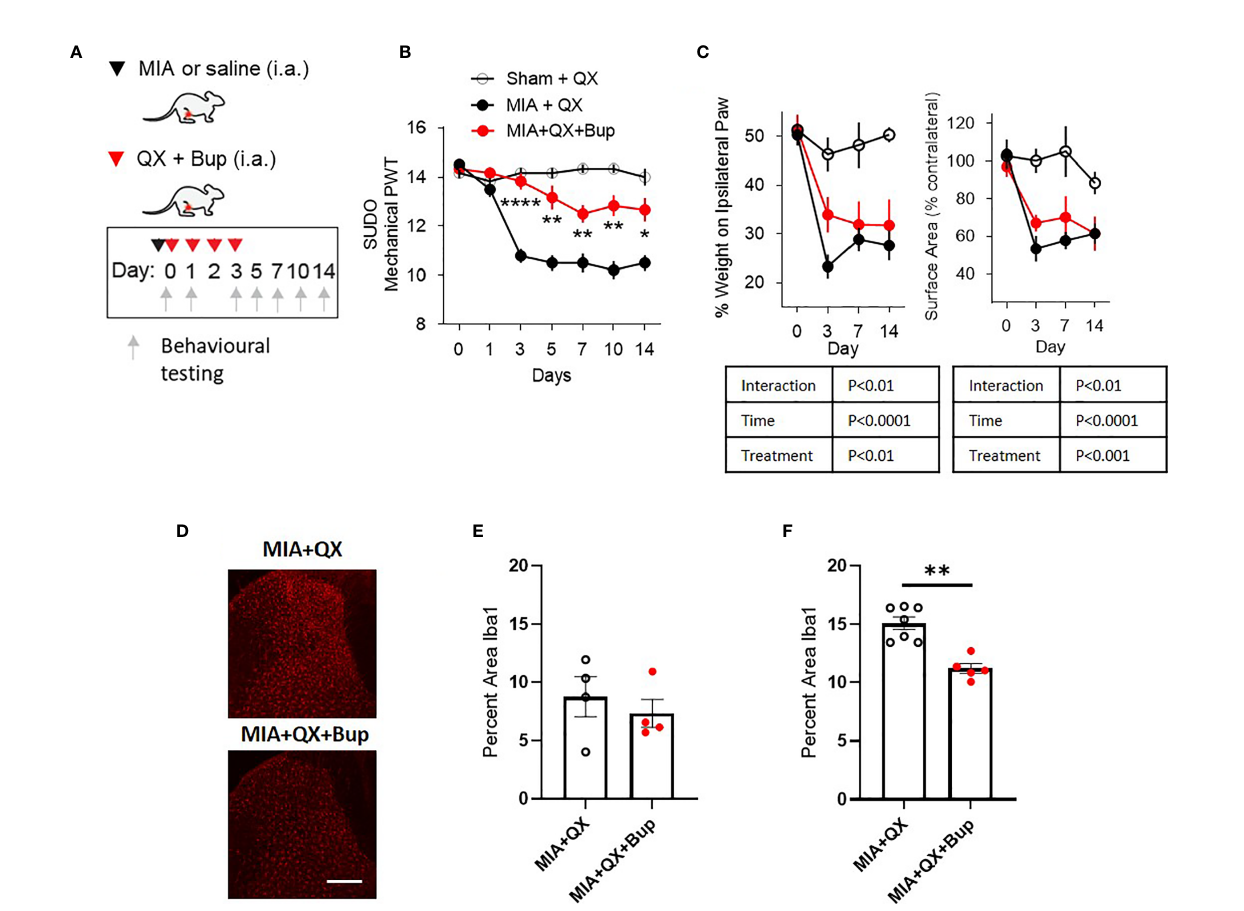
FIGURE 2 | Early pharmacological silencing of primary afferent alleviates mechanical allodynia and spinal microglial response. (A) Schematic diagram for MIA, QX- 314 (QX, 2%/25 m L) and bupivacaine (Bup, 10 m g/25 m L) administration. (B) Mechanical withdrawal thresholds after QX, MIA + QX alone and MIA with QX+ Bup, animals receiving QX alone after MIA injections developed signi fi cant mechanical allodynia, which was rescued by co-administration of QX and Bup (N=6 to 7 animals per group). (C) Effects QX and Bup co-administration on dynamic weight bearing behaviours after MIA injections (N=6 to 7 animals per group). (D) Representative images of Iba1 immunoreactivity in the ipsilateral dorsal horn 7 days after MIA injections with or without Bup. Scale bar = 200 m m. (E, F) Quanti fi cation of Iba1 immunoreactivity in the ipsilateral dorsal horn of QX and QX+Bup treated animals 7 days (E) and 14 days (F) after MIA injections (N=4 to 7 animals per group). *P < 0.05, **P < 0.01, ****P < 0.0001 comparisons between MIA+QX and